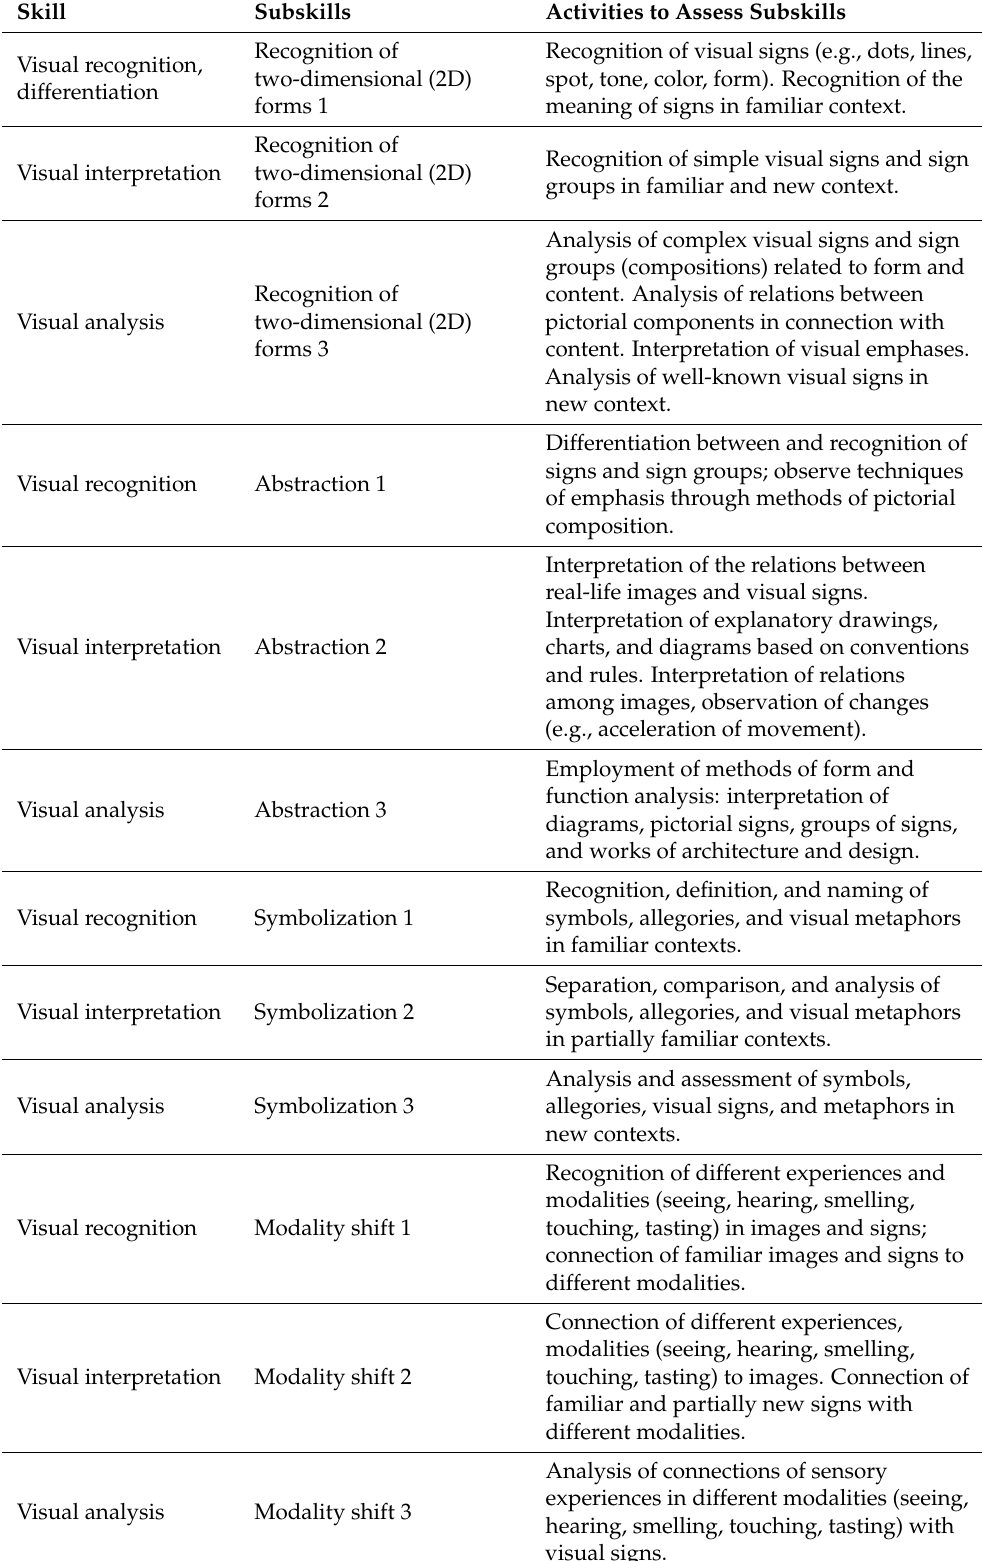
Table 2. The subskills selected to assess the “respond” domain of visual